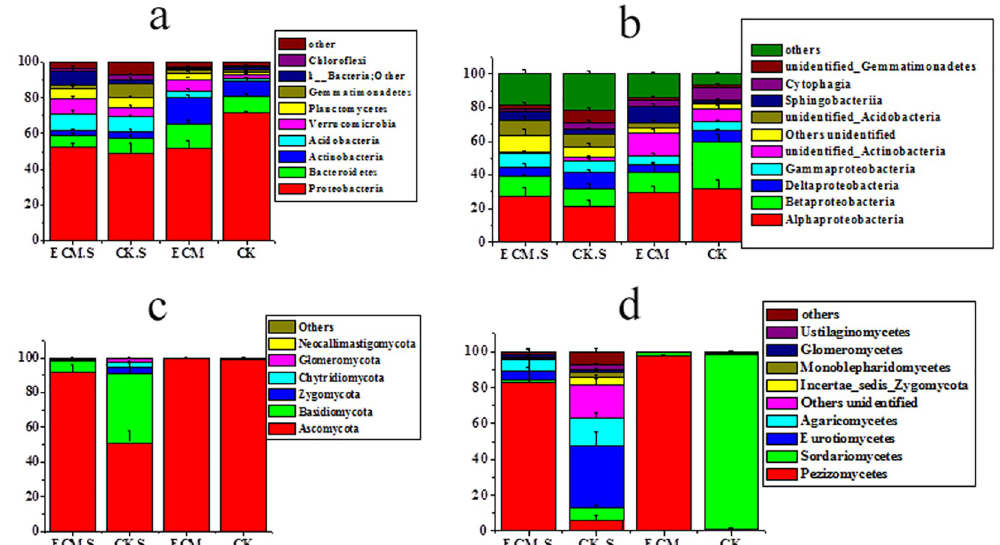
Fig 3. Taxonomic composition of bacterial and fungal communities associated with Pinus armandii root tips and surrounding soils at the phylum and class levels. ECM and ECM.S, ectomycorrhizae ( Pinus armandii mycorrhizedwith Tuber indicum )and ectomycorrhizospheresoil. CK and CK.S, roots and soils from cultivated P . armandii without T . indicum partner. a, bacterialphyla; b, bacterialclasses; c, fungal phyla; d, fungal classes. All experiments were conductedin triplicate.